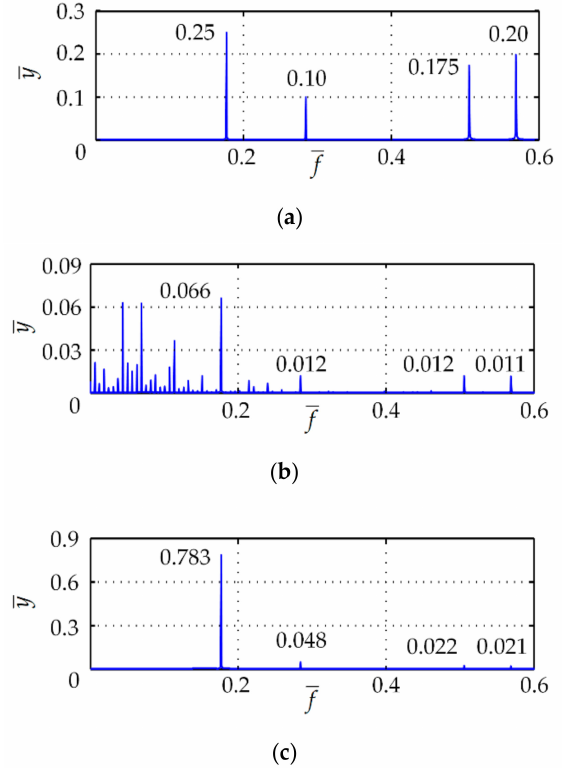
Figure 15. Spectrums under multi-frequency wave excitation. ( a ) displacement excitation; ( b ) displacement response of QZS isolator; ( c ) displacement response of equivalent linear